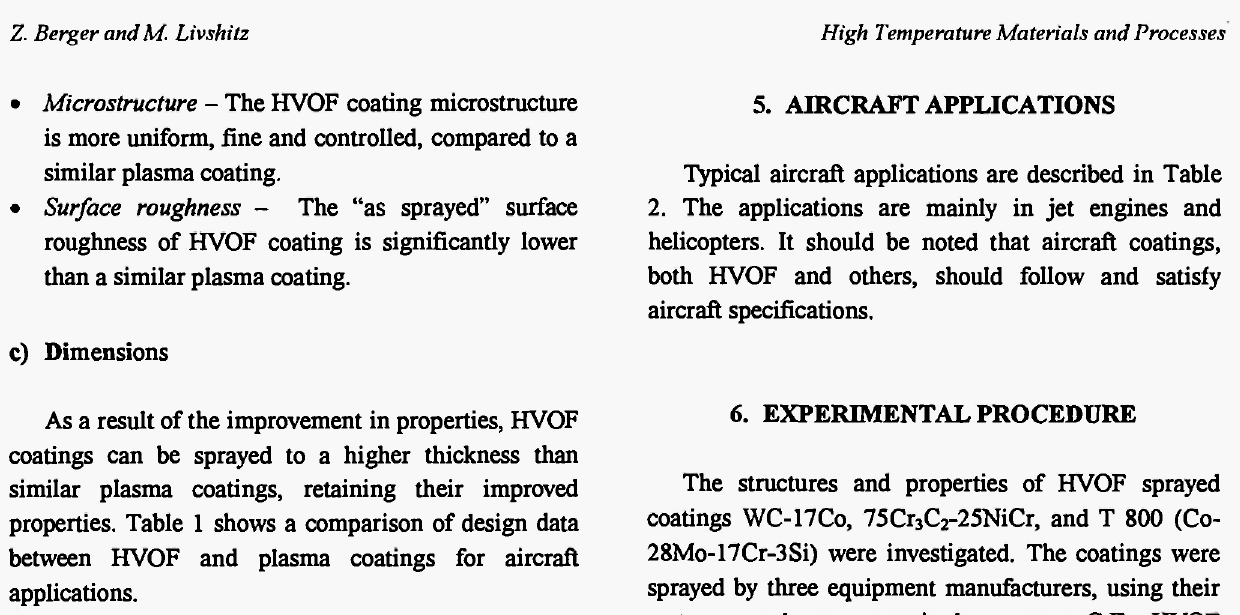
Coating thickness comparison (design data), HVOF and APS. Aircraft application